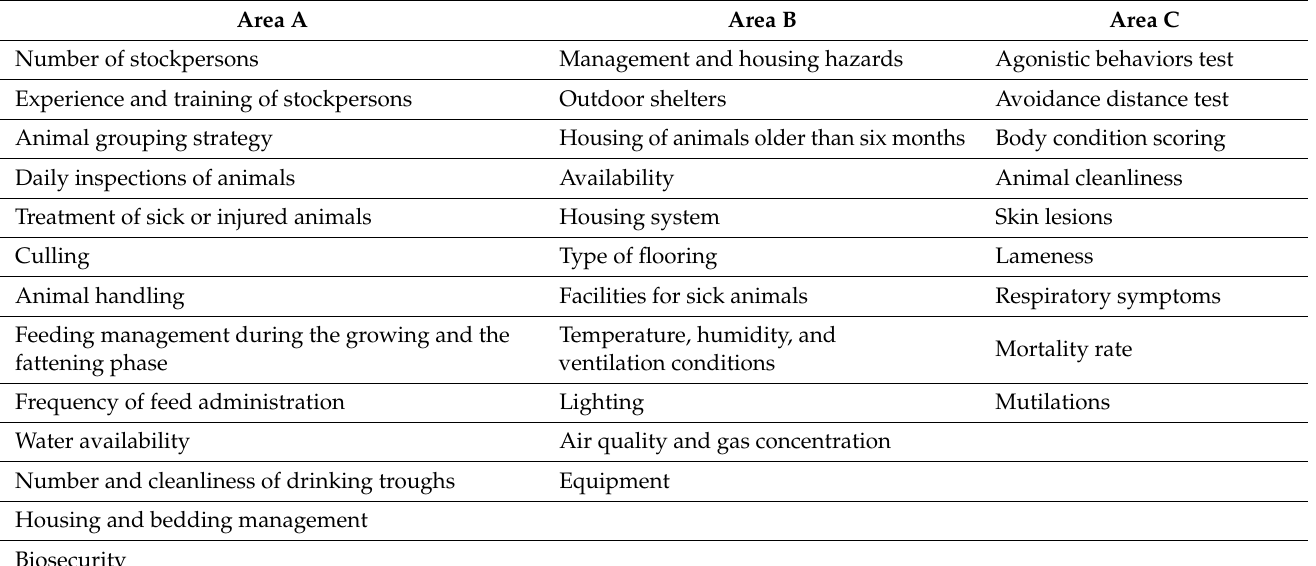
Table 2. Main items in the three